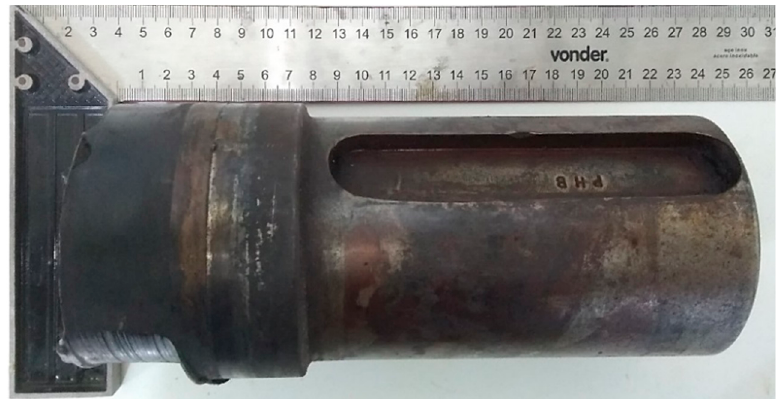
Figure 2. Fractured shaft of the speed reducer.